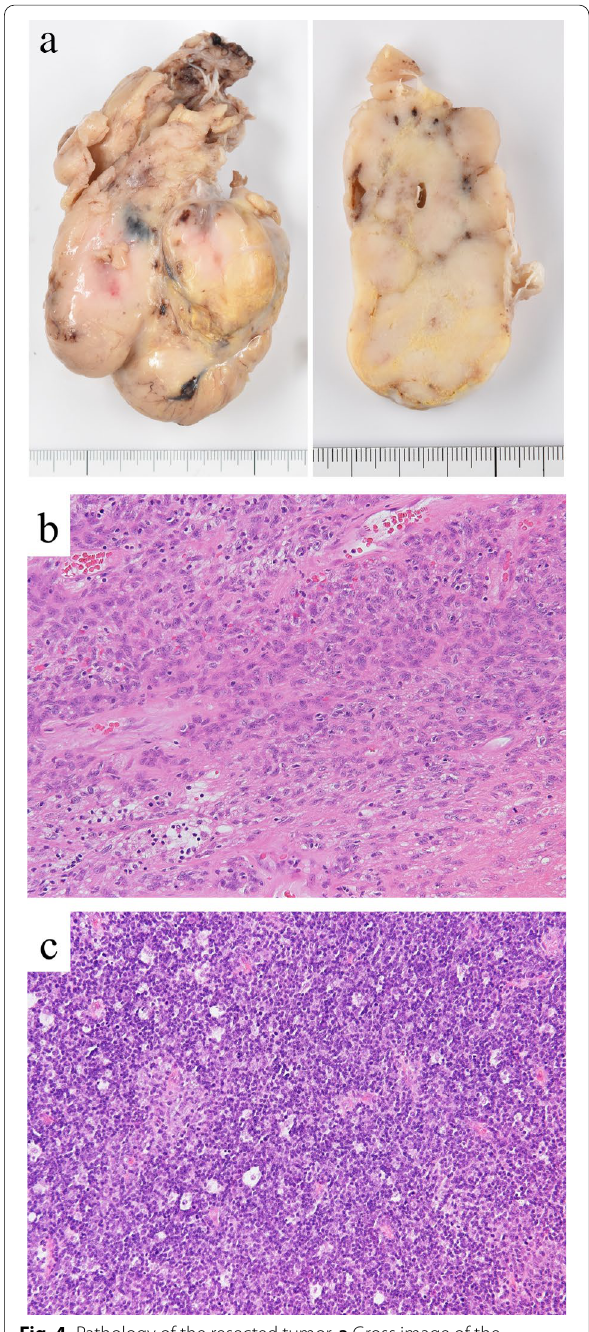
Fig. 4 Pathology of the resected tumor. a Gross image of the intracardiac mass showing a bosselated outer appearing light tan in color (left) and a lobulated cut surface with small cysts (right). Note a completely smooth surface of the tumor. b A representative histological image of a lymphocyte-poor (type A-like) area. Tumor cells with oval, bland nuclei and eosinophilic cytoplasm proliferate in solid sheets. Small numbers of lymphocytes are seen (hematoxylin–eosin stain, 200). c Histological image of a lymphocyte-rich (type B-like) × area. A small number of epithelioid tumor cells are intermingled along with a starry sky appearance (hematoxylin–eosin stain, ×